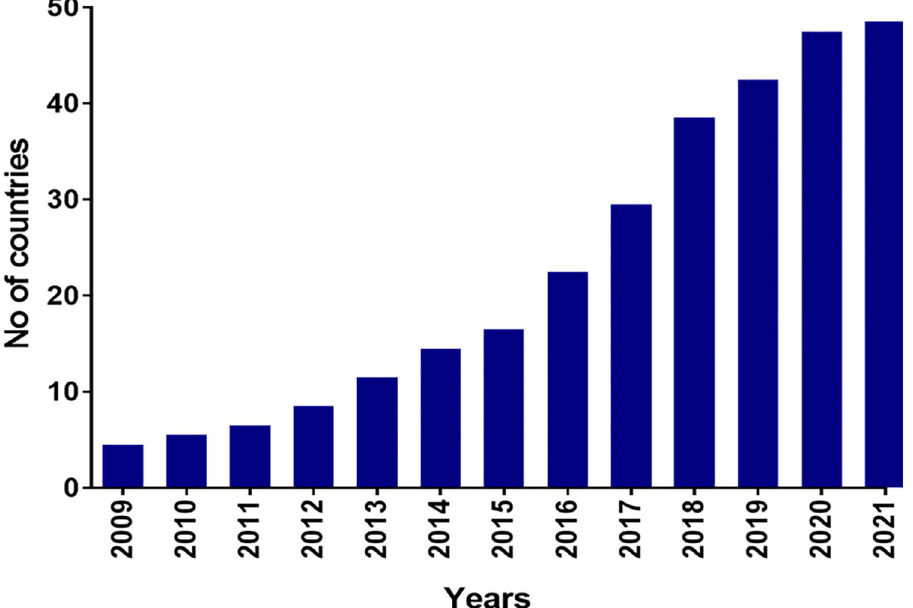
Fig 1. Cumulative number of countries with reported detection of Candida auris